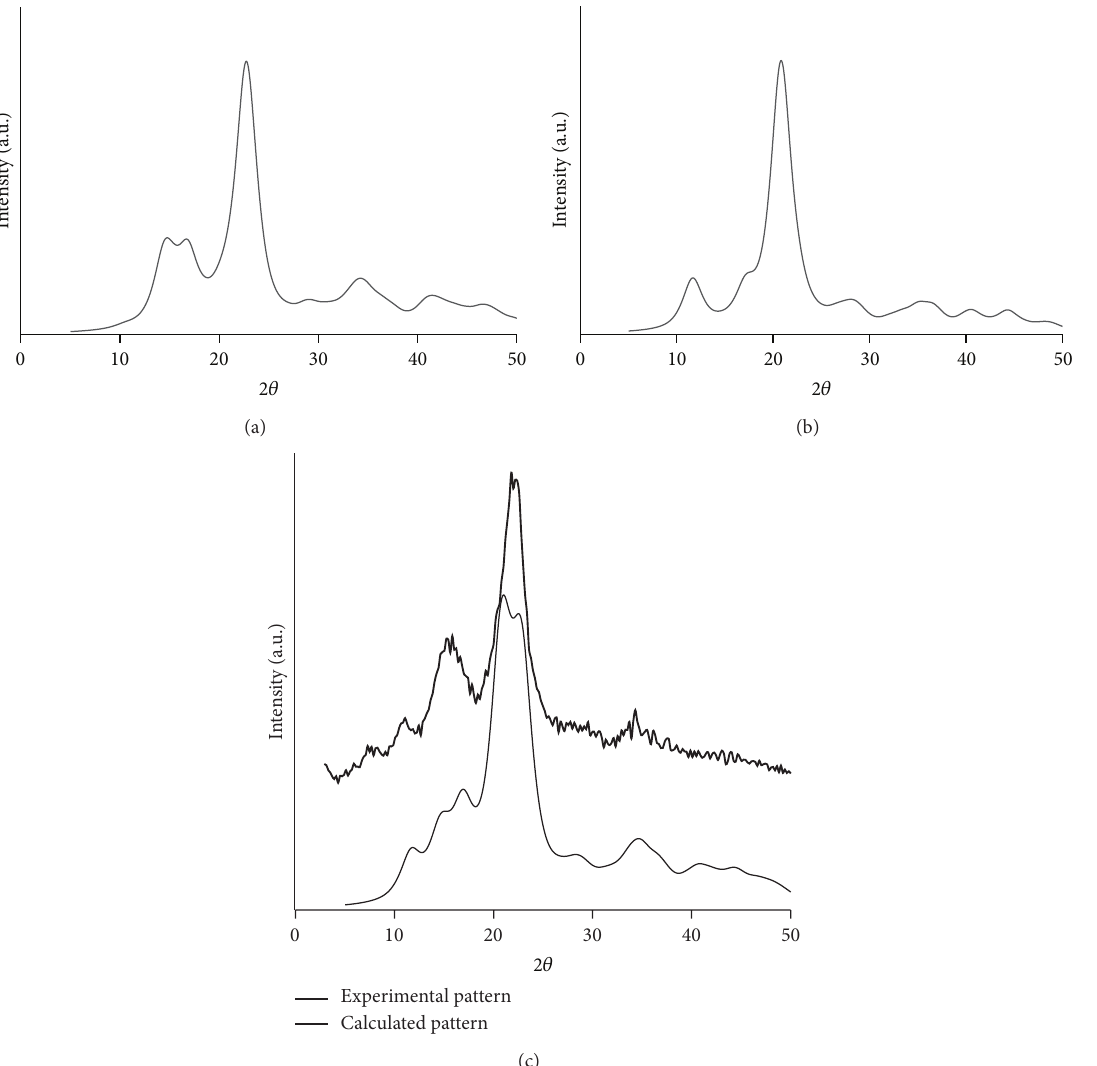
Figure 3: Revealing calculated patterns for CI 𝛽 and CIII ( patterns (c).